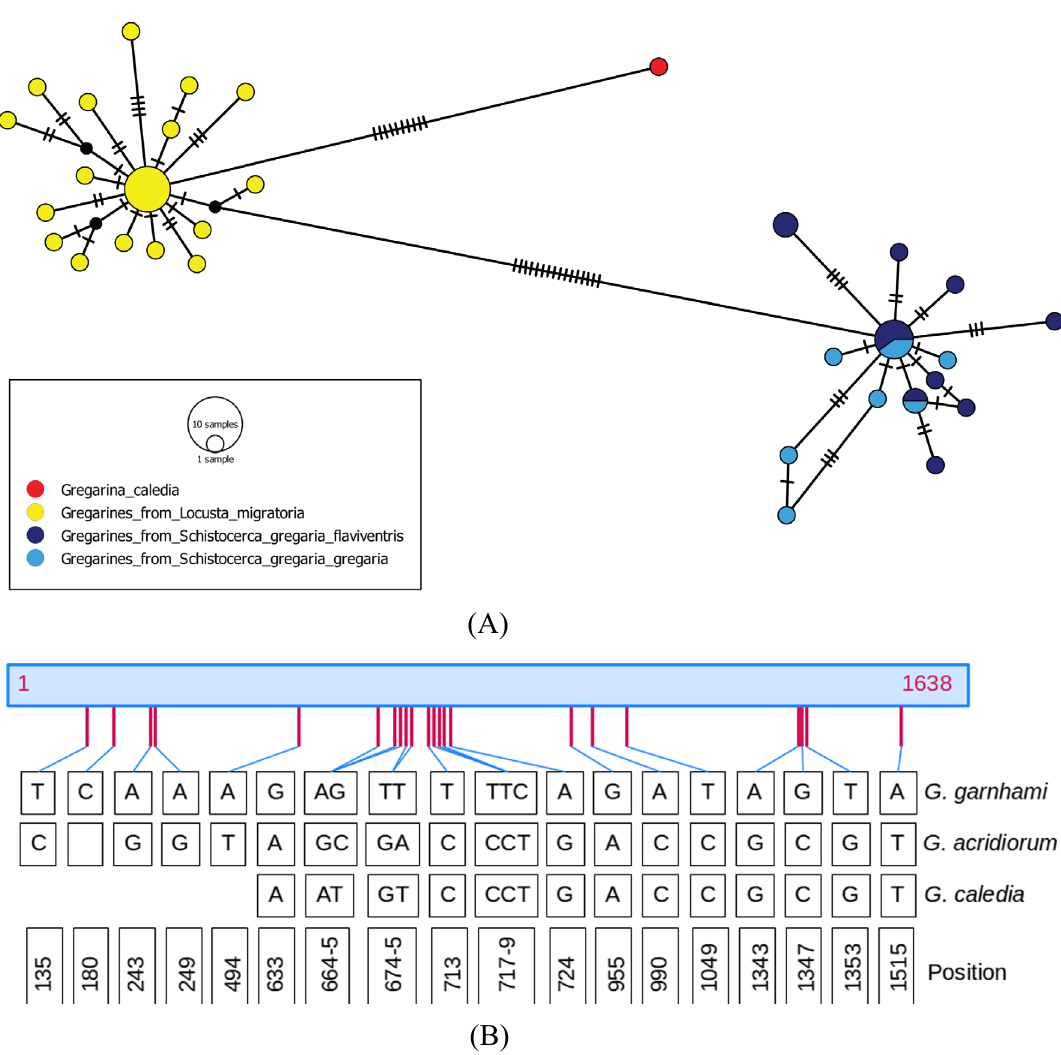
Figure 2. A: Minimum spanning network for the 43 cloned sequences of the SSU rDNA region studied, and the published sequence of G. caledia (L31799). Each link between haplotypes indicates one mutation, including indel events. The colors indicate the species or subspecies of the host. This network was inferred using POPART [25]. B: Distribution of the 22 polymorphic positions in SSU rDNA locus regions V1- V8 (1638-bp), between type 1 (presumably G. garnhami ) ( n = 20) and type 2 (presumably G. acridiorum ) ( n = 23) sequences, ampli fi ed from gregarines parasitizing respectively S. gregaria and L. migratoria . The corresponding positions are also given for G. caledia (L31799, 1210 bp) parasitizing Caledia captiva . Eleven additional positions, otherwise conserved between G. garnhami and G. acridiorum sequences, are modi fi ed in G. caledia sequence: site 1059, G deletion; sites 1161-1164: GAGC substituted by AG-G; site 1181: G substituted for C; site 1187: G substituted for A; sites 1231 and 1240: T substituted for C; site 1493: T insertion; site 1584: G substituted for